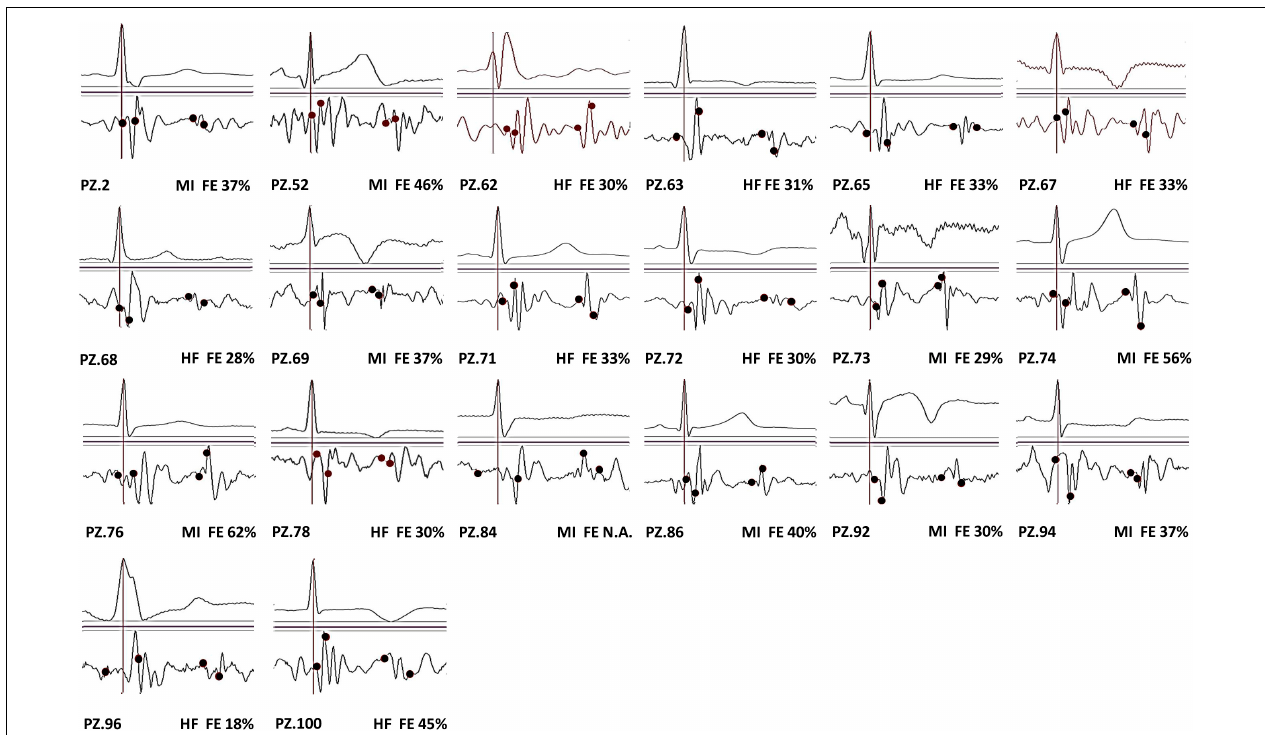
FIGURE 5 | SCG T waveforms from 20 patients with the superimposition of the real location of MC, AO, AC, and MO events (in each panel represented in sequence by the black circles from left to